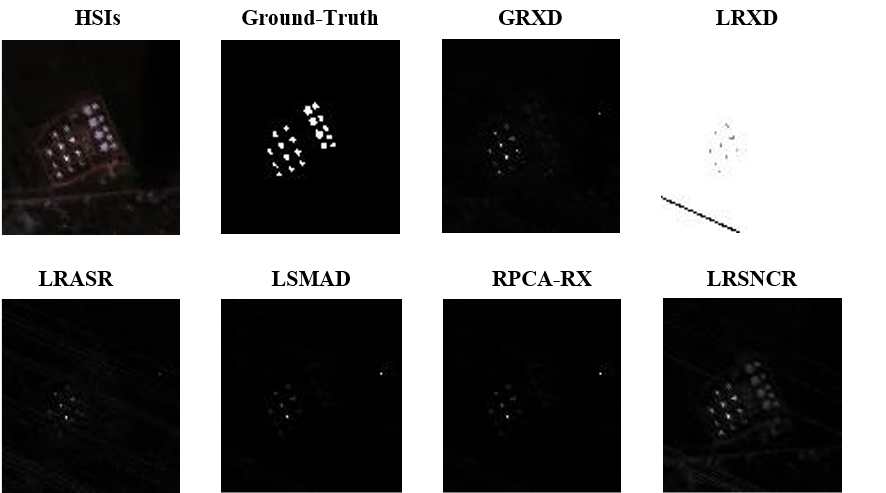
Figure 16. Detection maps by ABU-urban